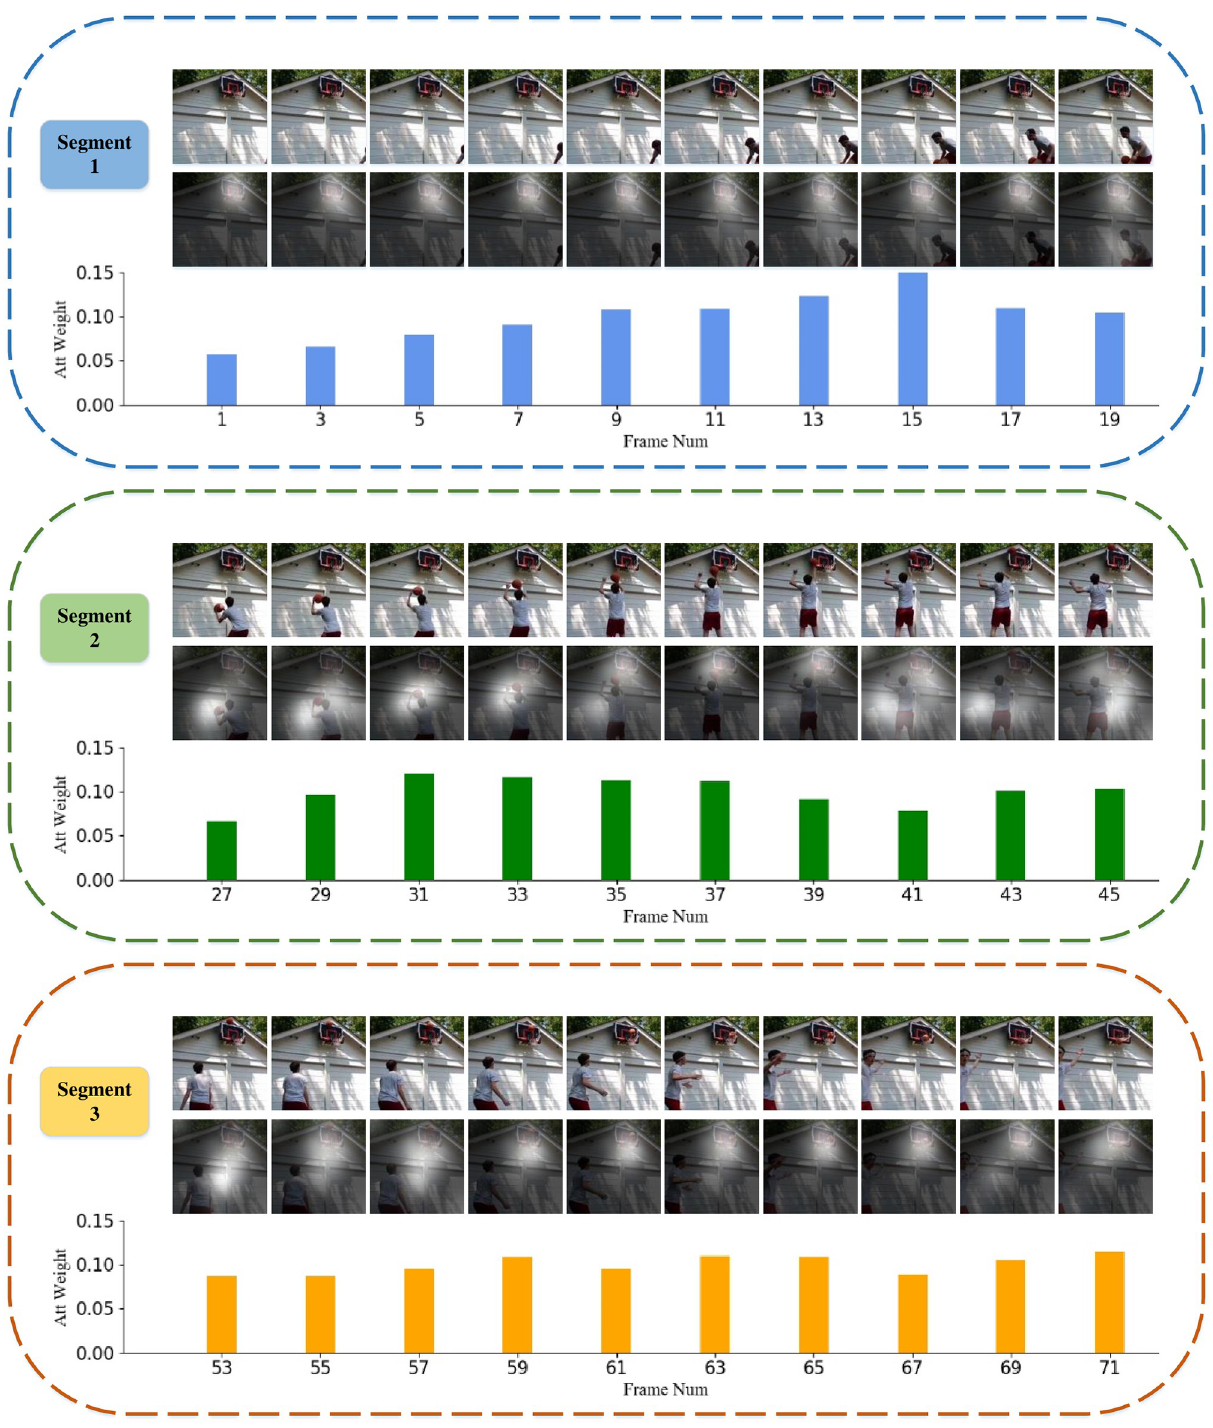
Fig 6. The visualization results of our STA-TSN for “shoot ball” in HMDB51. The first line is RGB images cropped from the center to a size of 224 × 224. The second line is RGB images with spatial attention masks, where the brightness indicates the focus level in space. The third line is the histogram of the temporal attention weights of the corresponding frames. Reprinted from [10] under a CC BY license, with permission from IEEE publisher, original copyright 2018.